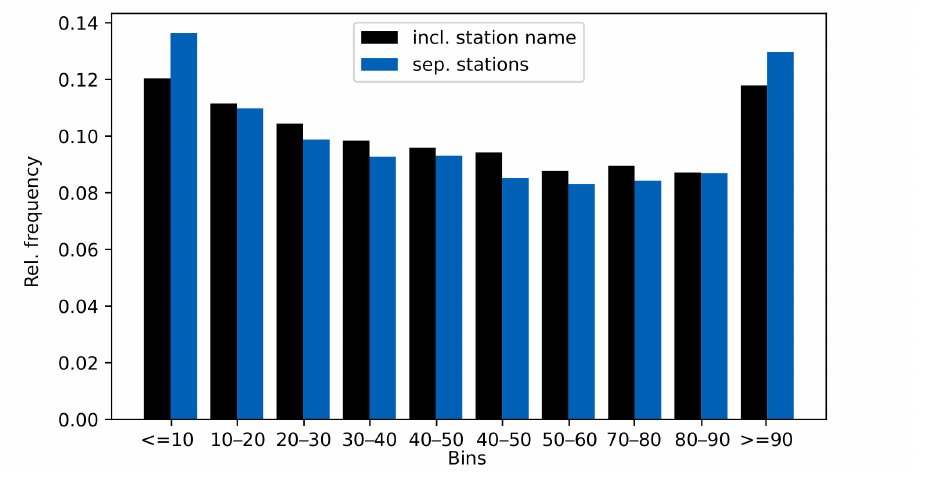
Figure 11. Rank histogram based on percentiles 90, 80, ...10. Relative frequency of observations in each of these